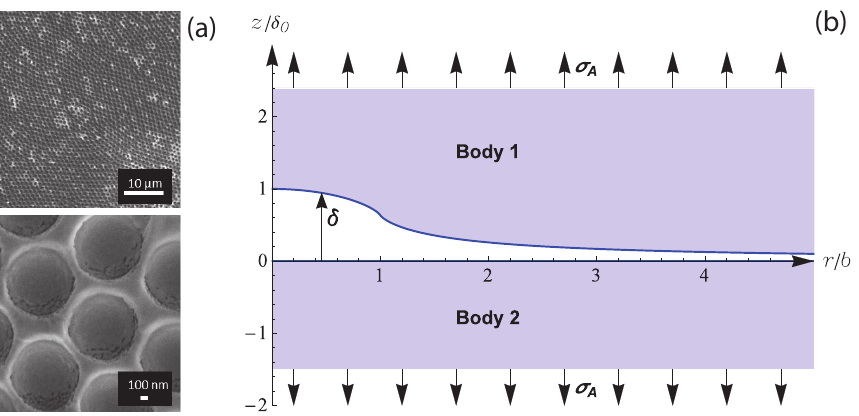
Figure 1. ( a ) SEM images of a surface pattered with dimples (adapted from [9]). ( b ) Geometry of the dimple surface considered in this study. The model is